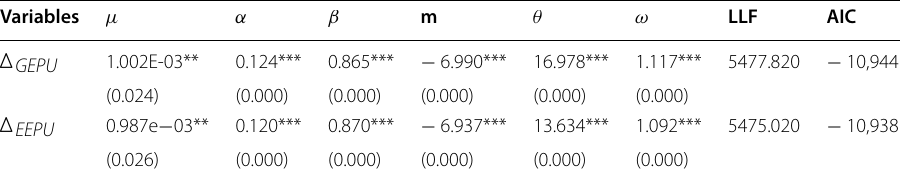
Table 3 Full-sample estimates of GARCH-MIDAS models